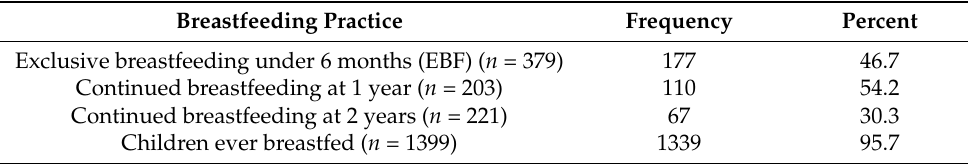
Table 2. Breastfeeding practices among the study participants ( n = 1399).